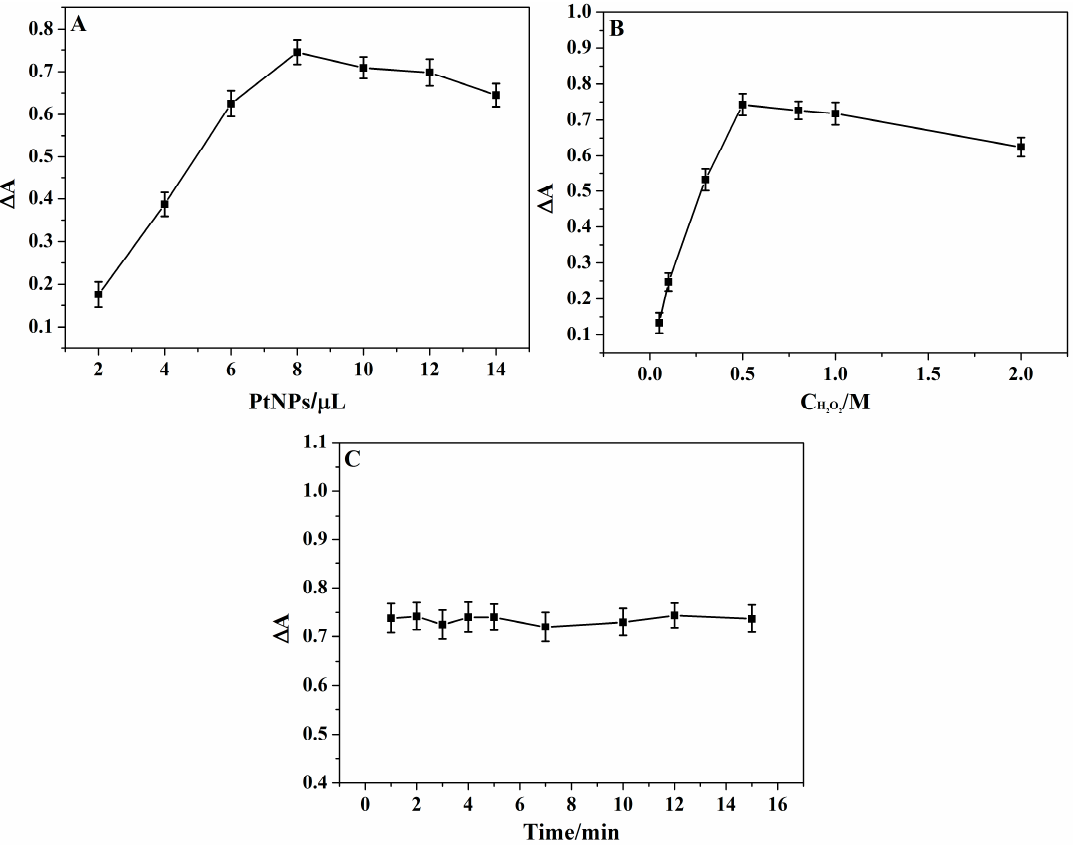
Figure 8. The effect of experimental conditions on the sensing performance ( A ) the volume of citrate-modified PtNPs; ( B ) the concentration of H 2 O 2 ; and ( C ) the reaction time between Ag + and PtNPs.